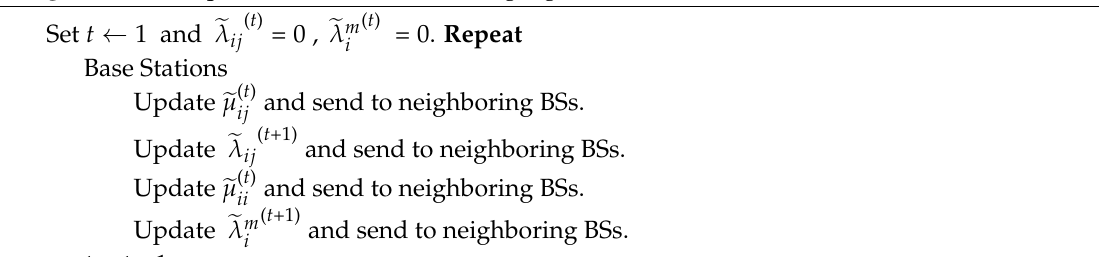
Algorithm 1: Proposed distributed clustering